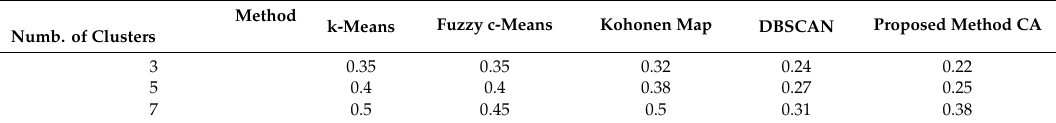
Table 2. Results of the Hopkins statistics method for evaluation of clustering methods.